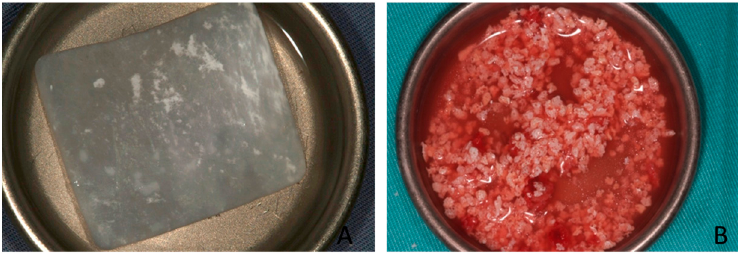
Figure 6. ( A ) A short-term absorbable collagen membrane; ( B ) Grafting materials mixed with venous blood.